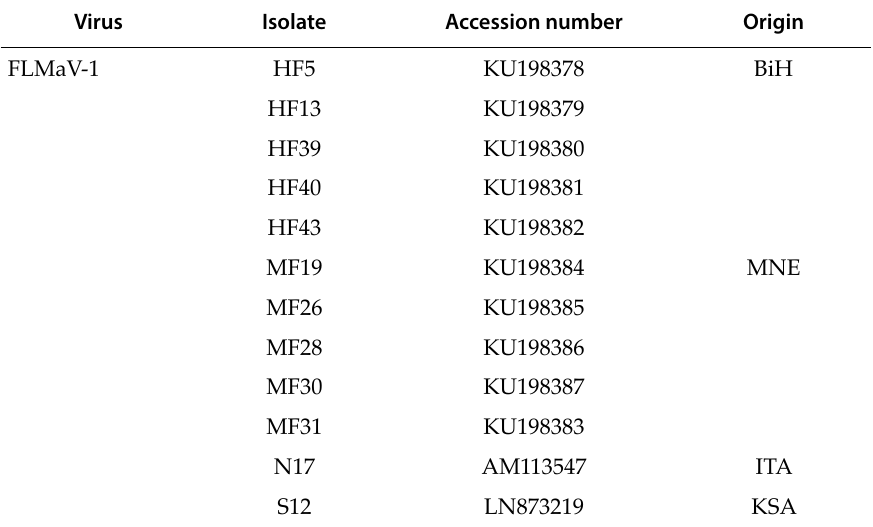
Supplementary Table 2. List of isolates of Fig leaf mottle-associated virus 1 (FLMaV-1), Fig leaf mottle-associated virus 2 (FLMaV-2), Fig mild mottle-associated virus (FMMaV), Fig mosaic emaravirus (FMV), Fig fleck-associated virus (FFkaV), and Fig badnavirus 1 (FBV-1), used in sequence and phylogenetic analyses, together with their GenBank accession num- bers and geographical origins; Albania (ALB), Algeria (ALG), Bosnia-Herzigovina (BiH), Canada (CAN), Costa Rica